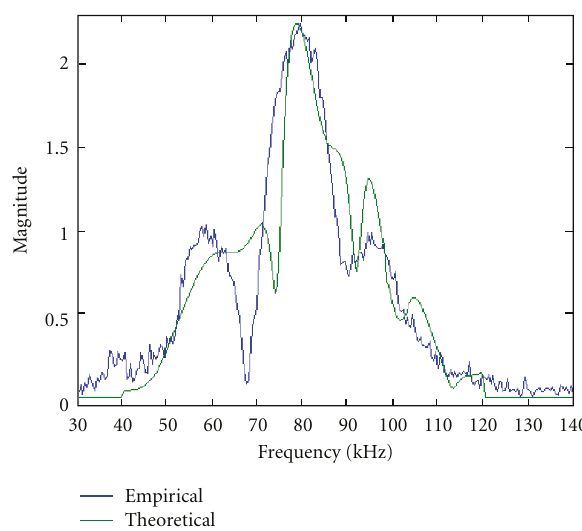
Figure 14: Comparison between theoretical and measured responses for the type C cable. Spacings between principal notches are well represented. Notch positions are sensitive to relative phases of contributing echoes and are readily a ff ected by any imprecision in values for acoustic properties of the